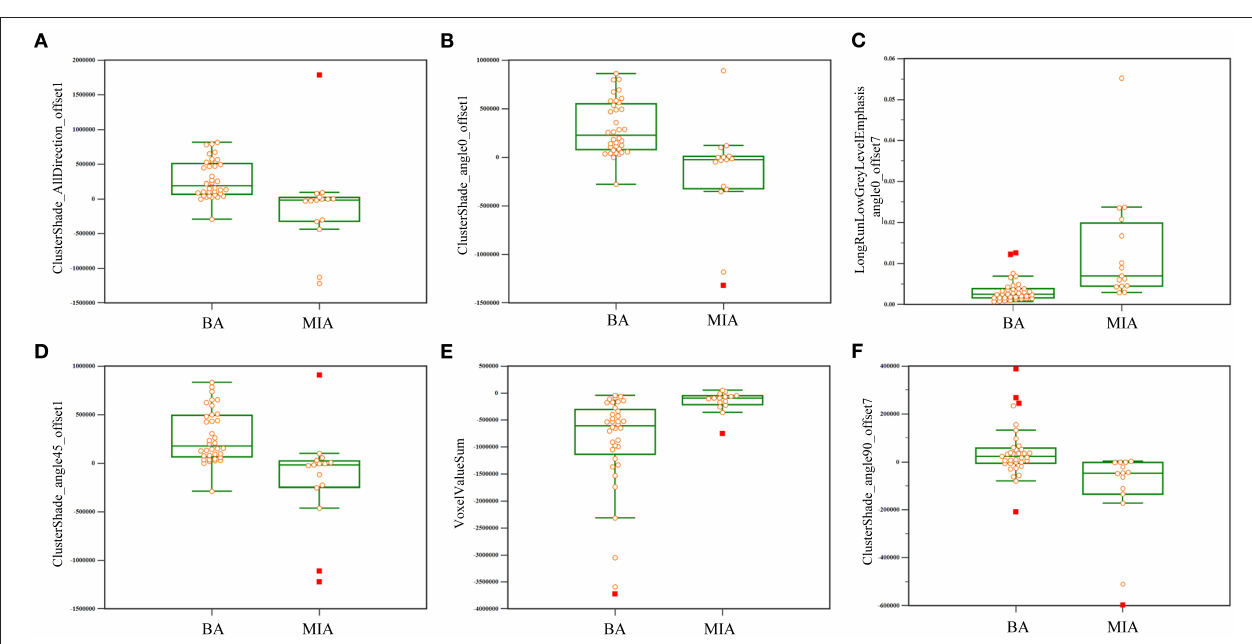
FIGURE 3 | Key texture features of the most significant difference between BA and AIS. Six features, namely, GLCMEntropy_AllDirection_offset1_SD (A) , LongRunLowGreyLevelEmphasis_angle45_offset7 (B) , GLCMEnergy_AllDirection_offset1_SD (C) , ShortRunEmphasis_angle0_offset1 (D) , VoxelValueSum (E) , and Quantile 0.975 (F) , varied significantly between BA and AIS on thin-section unenhanced CT images.